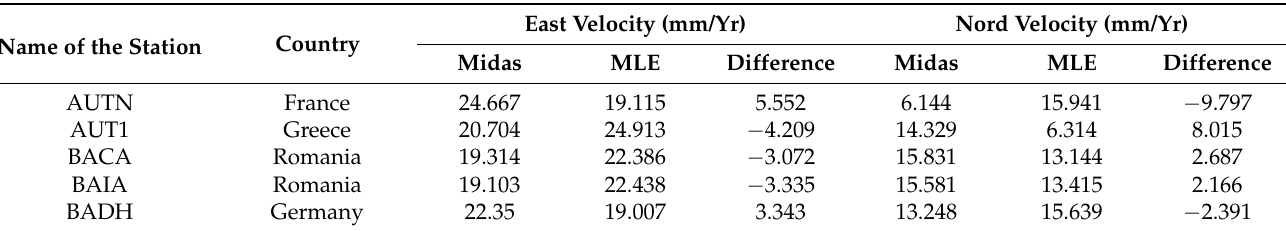
Figure 10. Stations’ velocity and their associated uncertainty for the horizontal component using MLE and MIDAS. Table 1. Difference of station velocity between MIDAS and